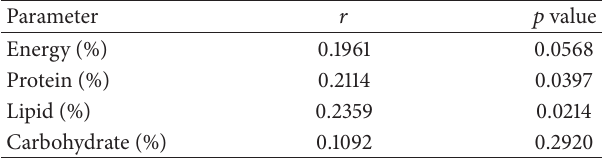
Table 5: Correlation analyses between body mass index and intake (%) of energy and each nutrient in patients with MAC lung disease.